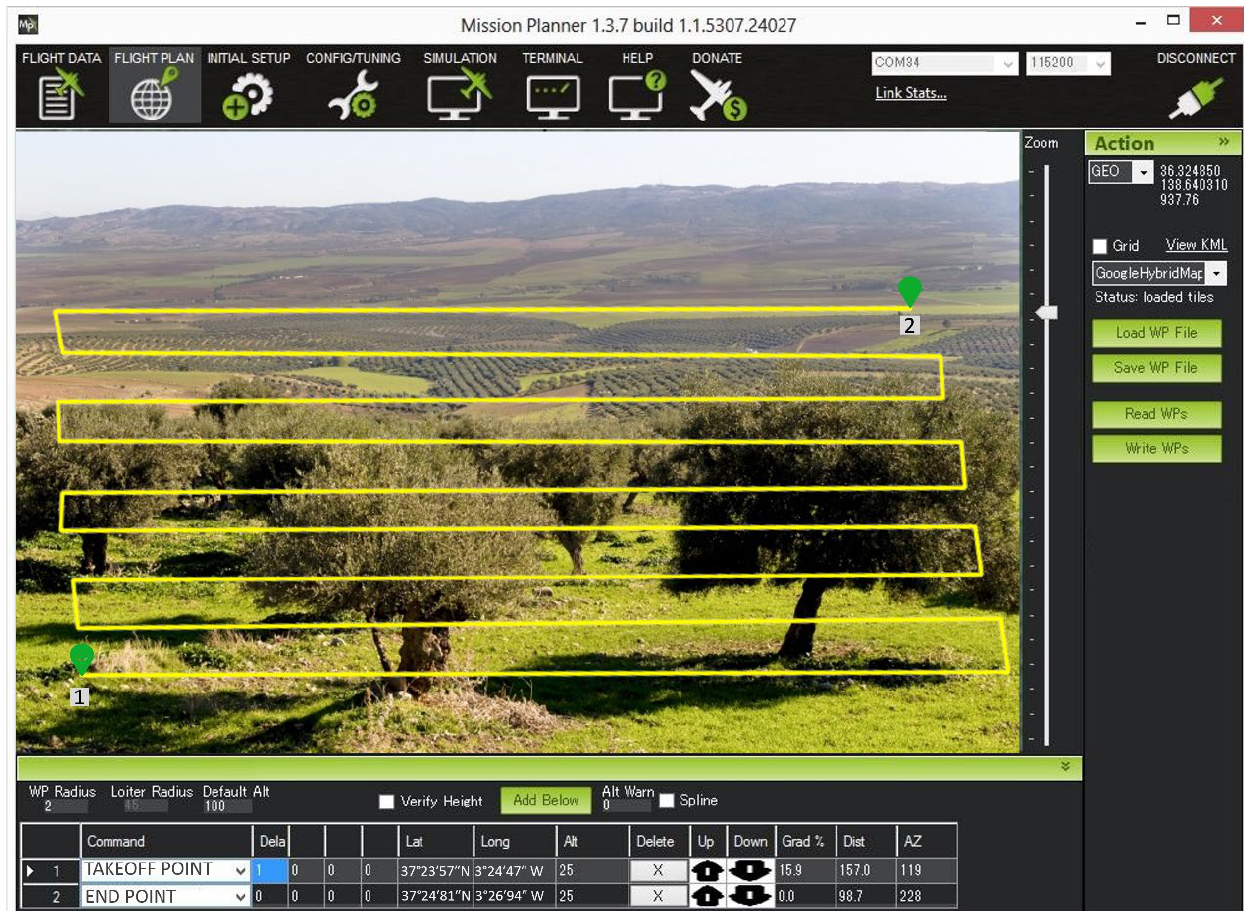
Figure 5. Drone path planning of topographic map using Mission Planner software.